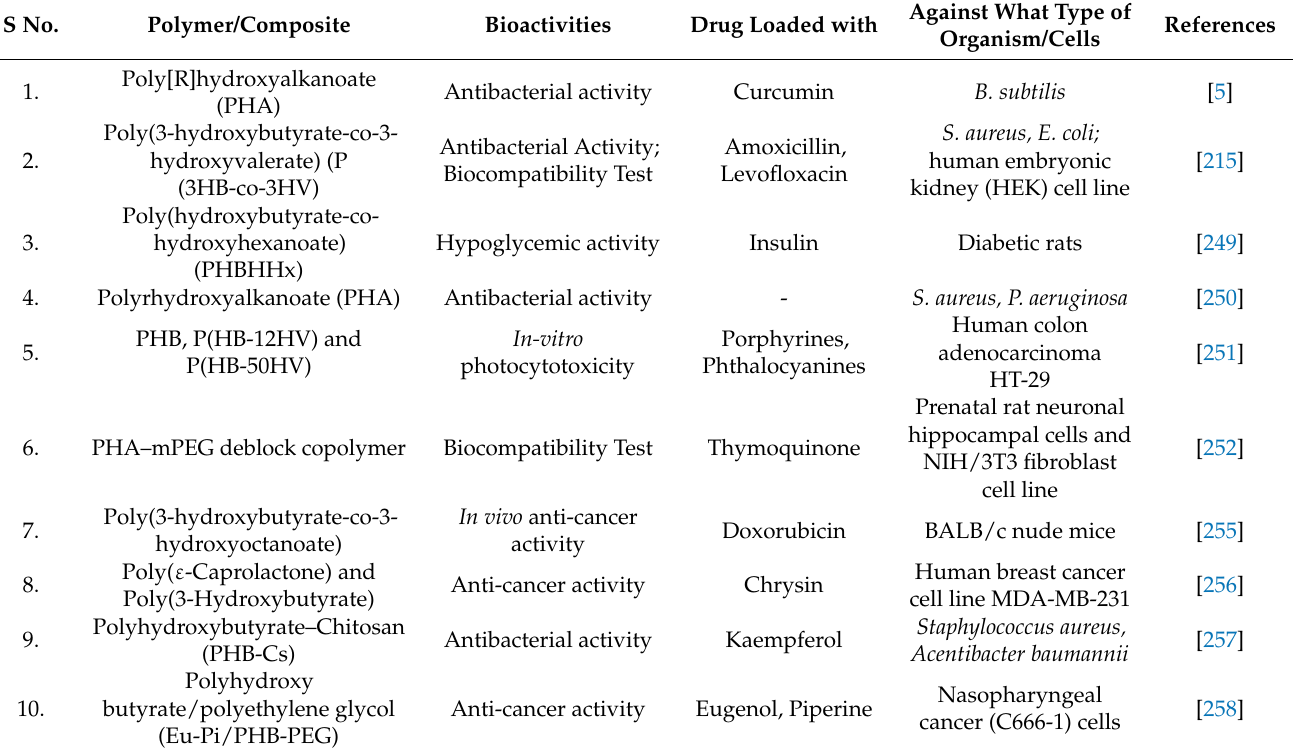
Table 2. Different applications of PHA